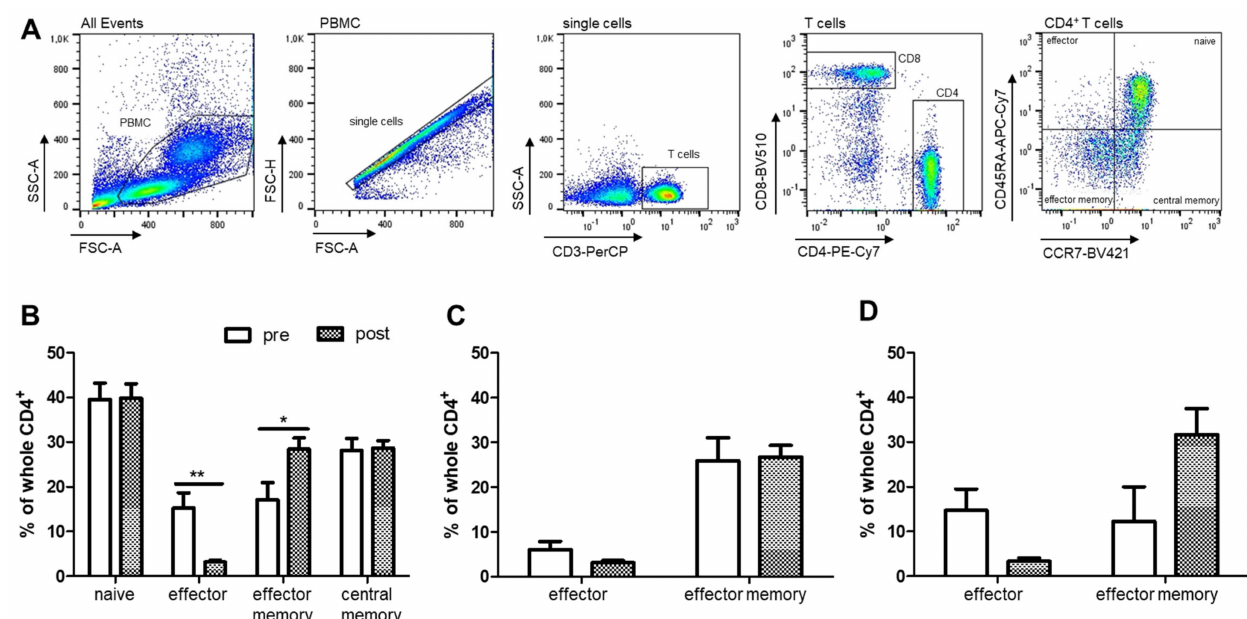
Figure 3. Flow cytometric analysis of CD4 + T cell subsets in PBMC from OSA patients ( n = 22) before and after PAP treatment. ( A ): Gating scheme of CD4 + T cell subsets from one representative patient. ( B ): Percentages of naïve, effector, effector memory and central memory CD4 + T cells. ( C ): Percentage of effector and effector memory CD4 + T cells in patients with initially moderate monocyte alterations. ( D ): Percentage of effector and effector memory CD4 + T cells in patients with initially severe monocyte alterations. *: p < 0.05; **; p < 0.01.